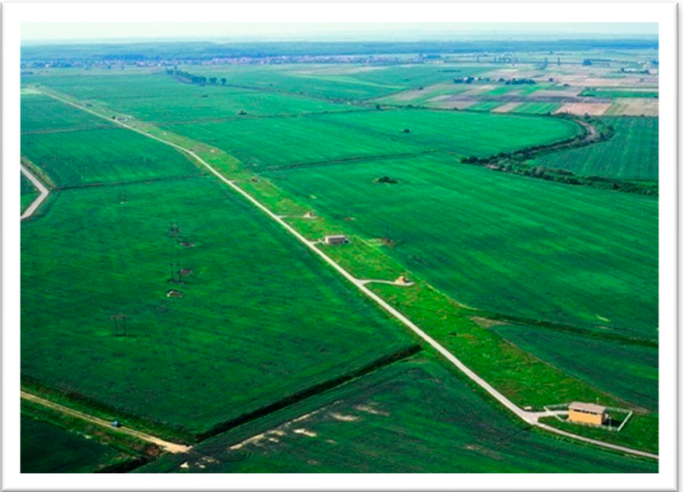
Figure 4. Photograph of the Vinogradi Pumping Station, Osijek, Croatia (Fund of documents of the company “Vodovod Osijek, Osijek, Croatia” 2000).